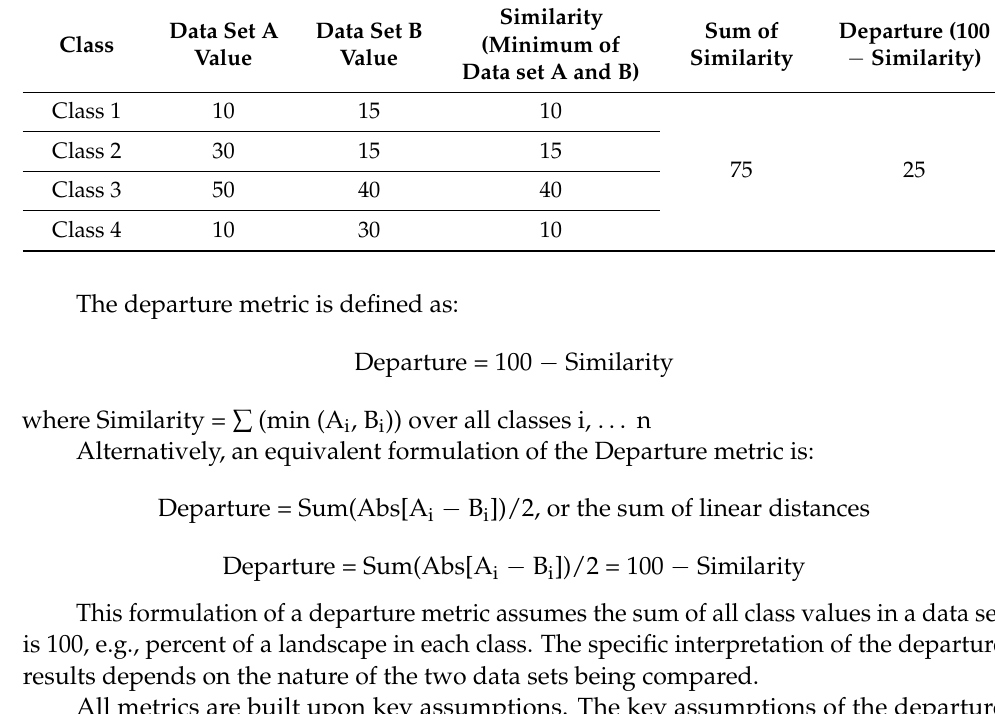
Table 1. Departure quantifies the difference between two data sets and is the inverse of